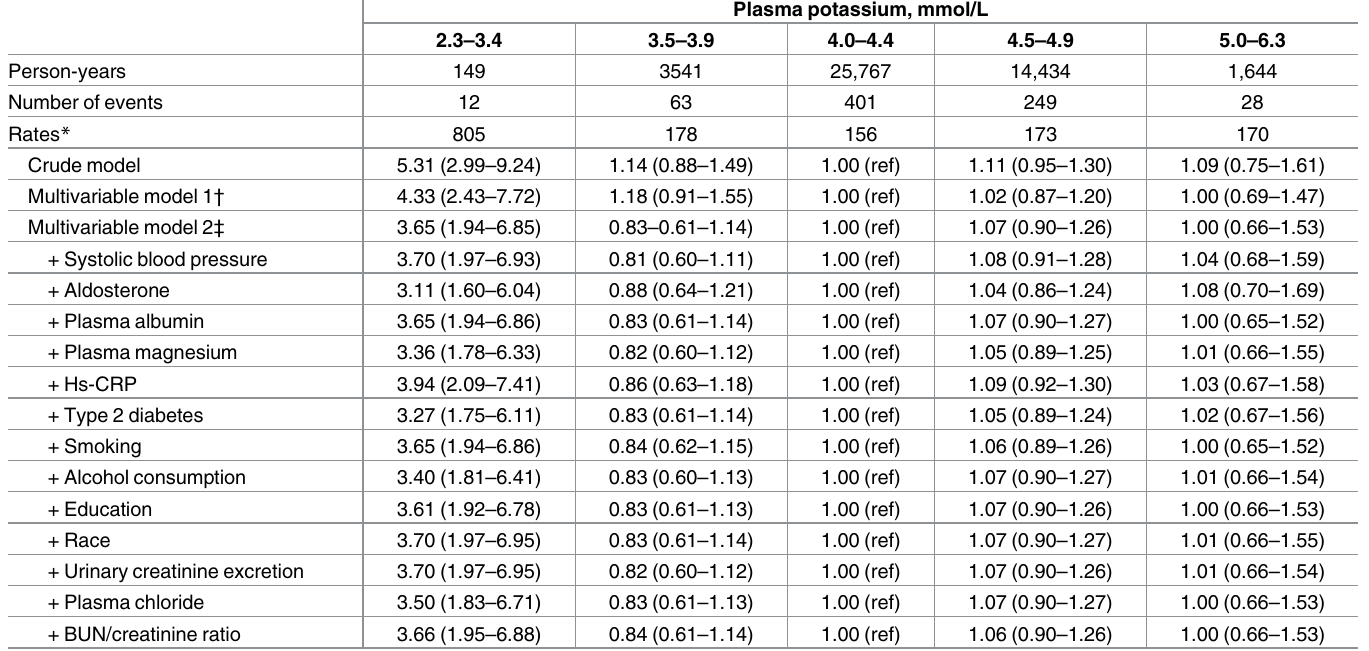
Table 3. Association of plasma potassium with risk of developing chronic kidney disease defined as eGFR creatinine-cystatin C < 60 ml/min/1.73m 2 or urinary albumin excretion > 30 mg/24h in 5,130 participants of the Prevention of Renal and Vascular End-Stage Disease(PREVEND)